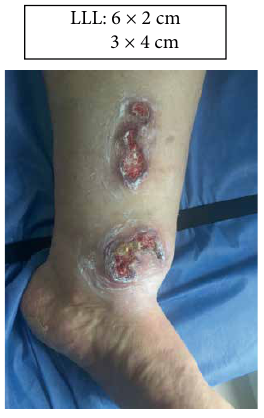
Figure 12: Start. Lower left limb.